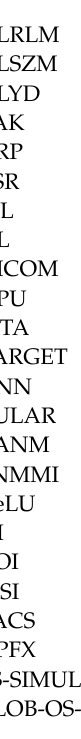
Table A1. PET reconstruction parameters for each PET-CT system. Key—BLOB-OS-TF =